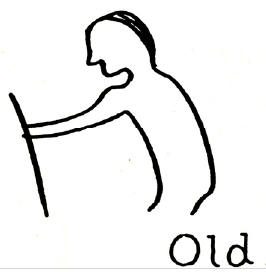
Figure 25. Picture-writing image informed by Old Cloud’s signature in Mallery (1886) (Publ. in Tomkins